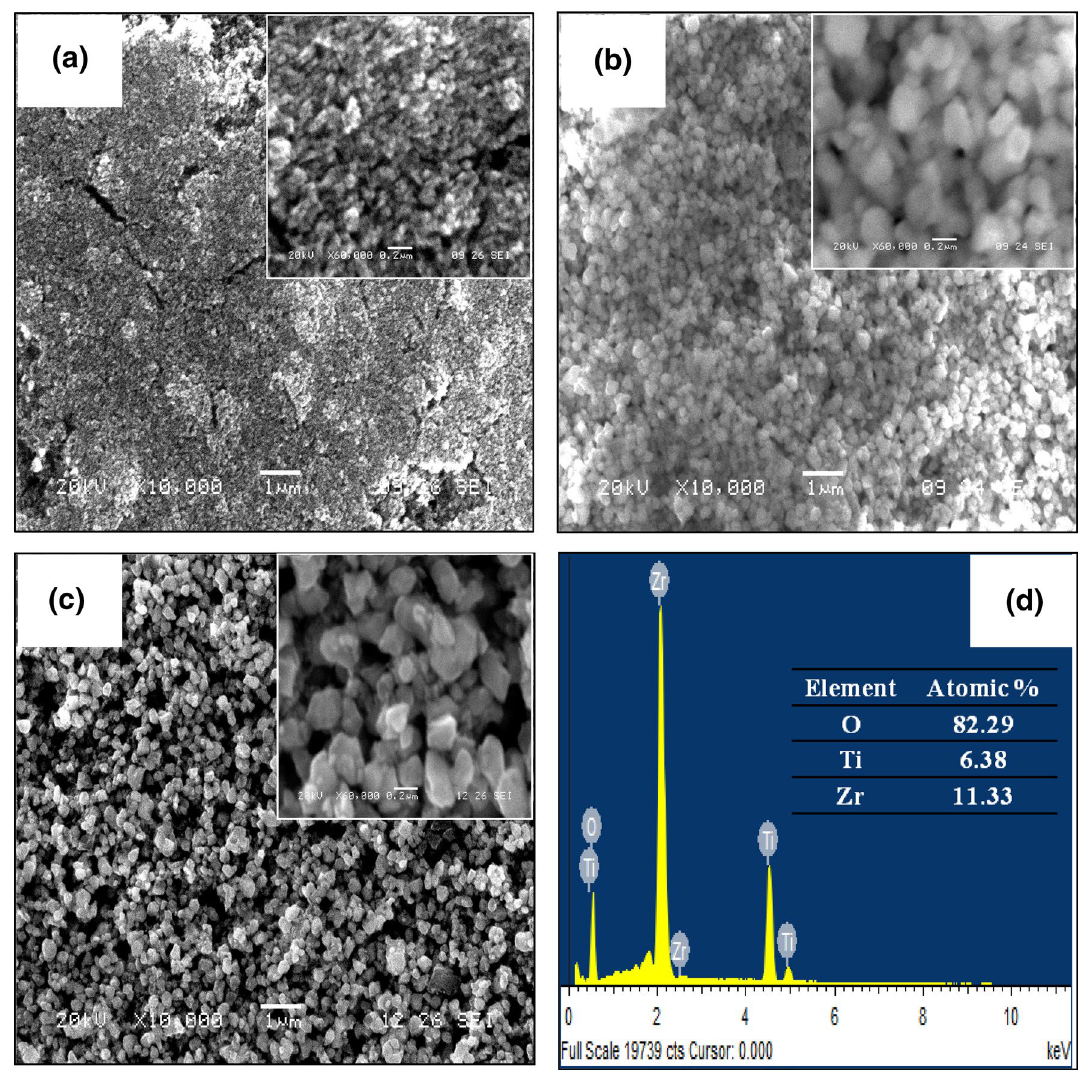
Fig. 3 Surface morphologies of a pristine TiO